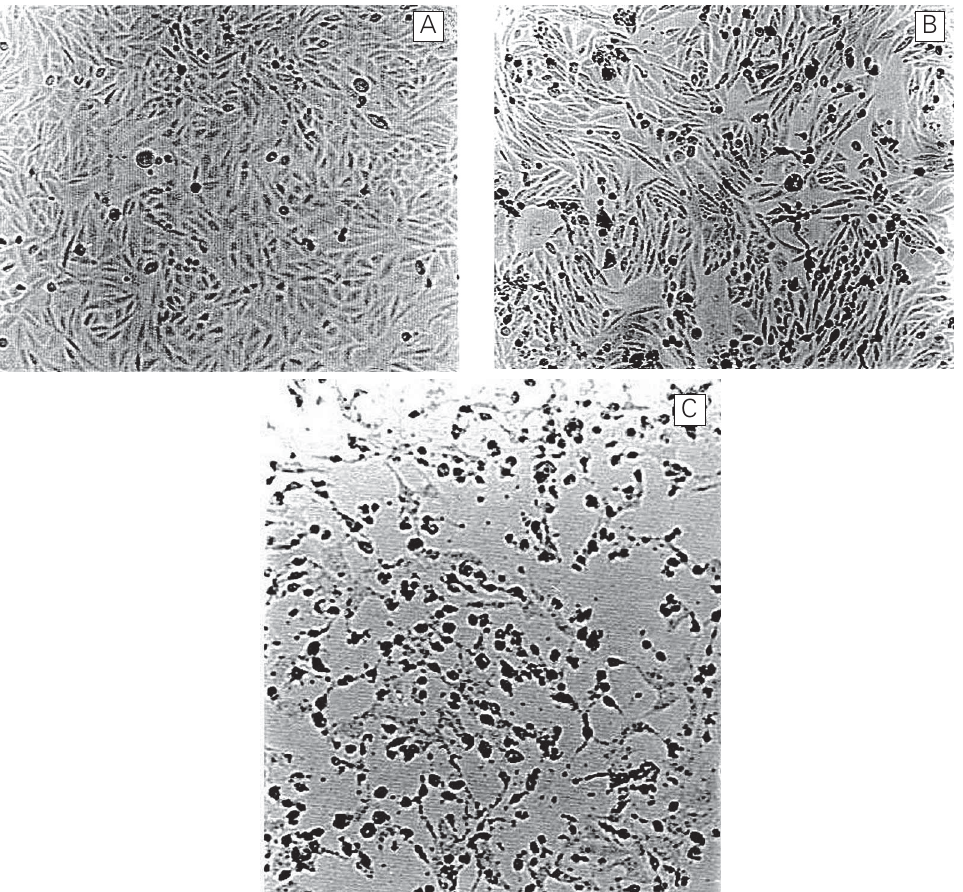
Figure 5. Effects of VT1 and CNF toxins on Vero cells in seroneu- tralization assays. A , Vero con- trol cells. B , Vero cells that re- ceived mixtures of antiserum against Serratia marcescens cy- totoxin incubated for 1 h at 37 º C with CNF toxin. C , Vero cells in- oculated with mixtures of anti- serum and VT